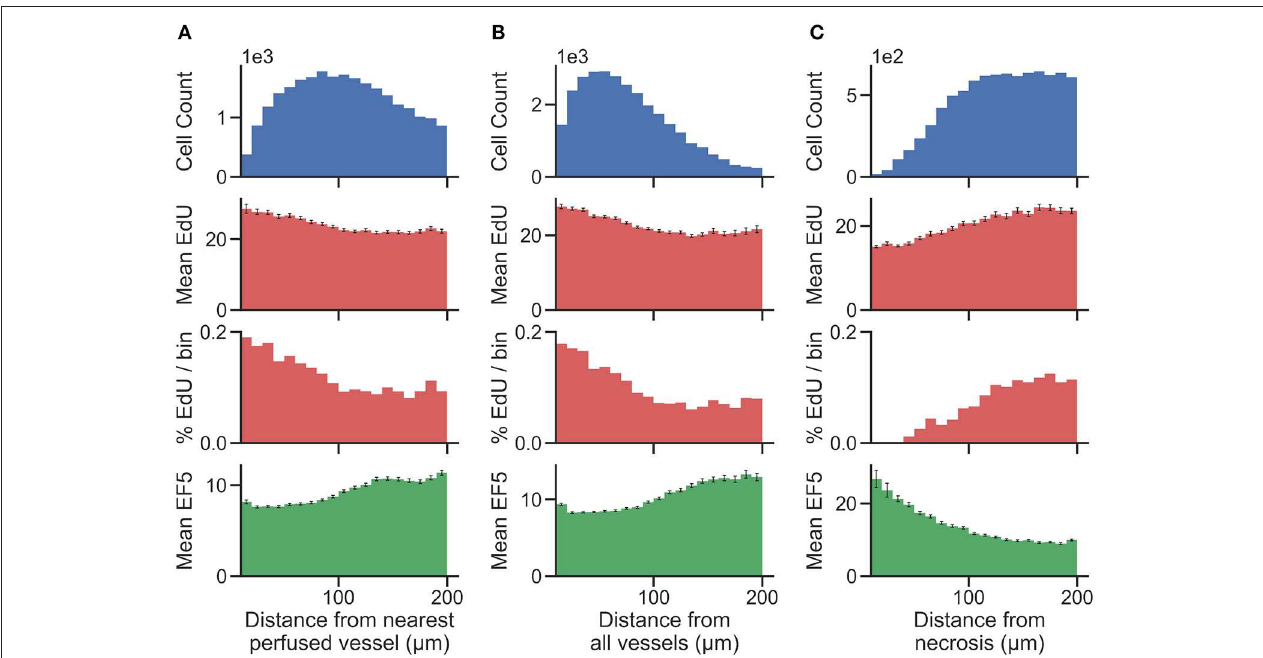
FIGURE 4 | Histograms showing the total number of cells (top) present within uniform distance bins measured from the region of interest [ (A) distance from the nearest perfused blood vessel, (B) distance from all blood vessels, and (C) distance from necrosis] in the image. The mean EdU intensity within all of the cells identified in these regions is shown (second from top, measured in arbitrary fluorescence staining units), as well as the mean EF5 staining intensity (bottom). Error bars correspond to the standard error of the mean of the marker intensity in each distance bin. We also utilize a threshold for positivity for EdU signal to identify EdU positive cells, and display the percent of cells in each distance bin that is positive for the EdU marker (second from